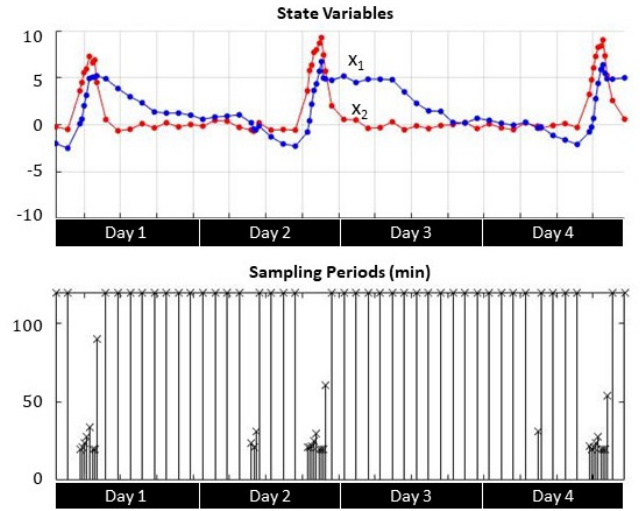
Figure 7. Self-triggered error-based state variable evolution and sampling periods.